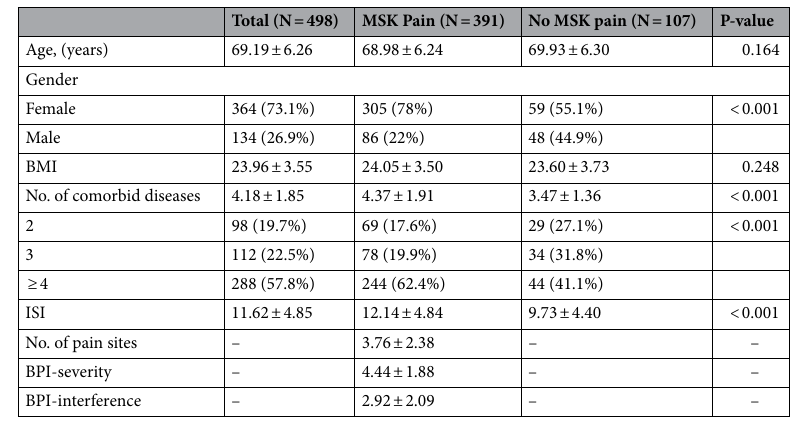
Table 1. Baseline background Data (N = 498) stratified by the presence of chronic MSK pain ^ (Mean ± standard deviation (SD) / count (col %)). ^ Abbreviations: BMI: Body Mass Index; BPI: Brief Pain Inventory; ISI: Insomnia Severity Index; MSK: